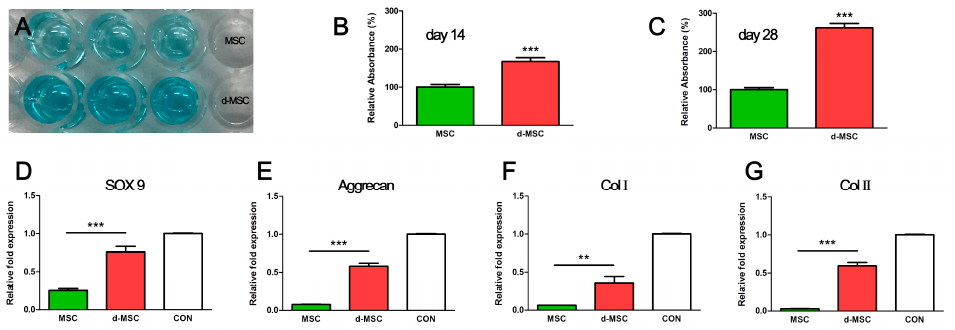
Figure 1. Relative GAG accumulation and chondrogenic marker gene expression level of MSC and d-MSC. ( A ) Alcian blue-stained dissolvents in a 96-well assay plate; the d-MSC group showed a deeper blue color than the MSC group. ( B , C ) Alcian blue absorbance on days 14 and 28. The d-MSC group showed 1.67 ± 0.10 (day 14) and 2.62 ± 0.11 (day 28) times higher values than the MSC group. The relative gene expression levels of SOX9 ( D ), aggrecan ( E ), collagen type 1 ( F ) and collagen type 2 ( G ) were increased in d-MSC. CON = expression level of chondrocyte as positive control. ** p < 0.01, *** p < 0.001.